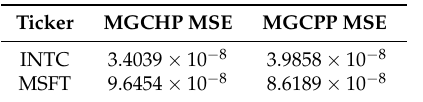
Table 5. The mean square error (MSE) of the real standard deviation and theoretical standard deviations from MGCHP and MGCPP.